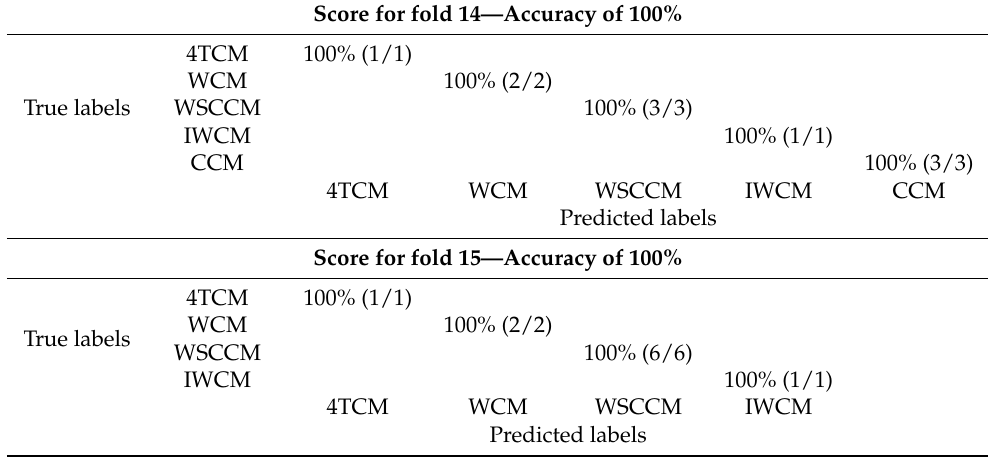
Score for fold 14—Accuracy of